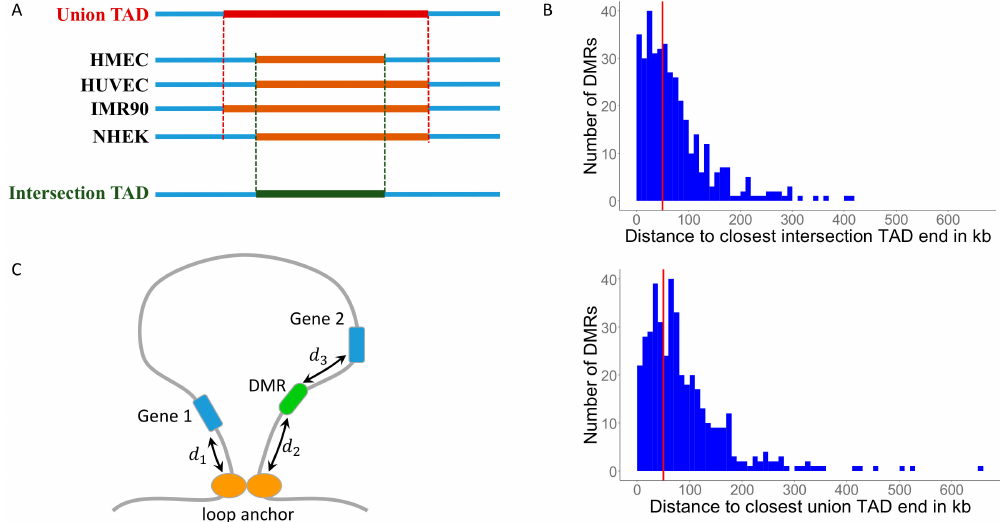
Figure 1. ( A ) Definition of a conserved Topologically Associating Domain (TAD) boundaries, as either the intersection of all intervals, or as their union. ( B ) Histograms of the distances between Di ff